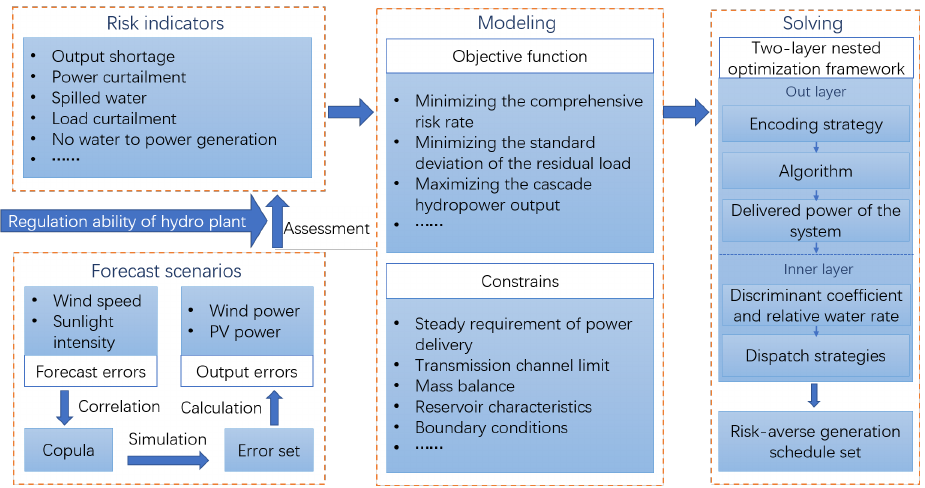
Figure 8. Schematic diagram for the operation scheme of wind-solar-hydro power considering